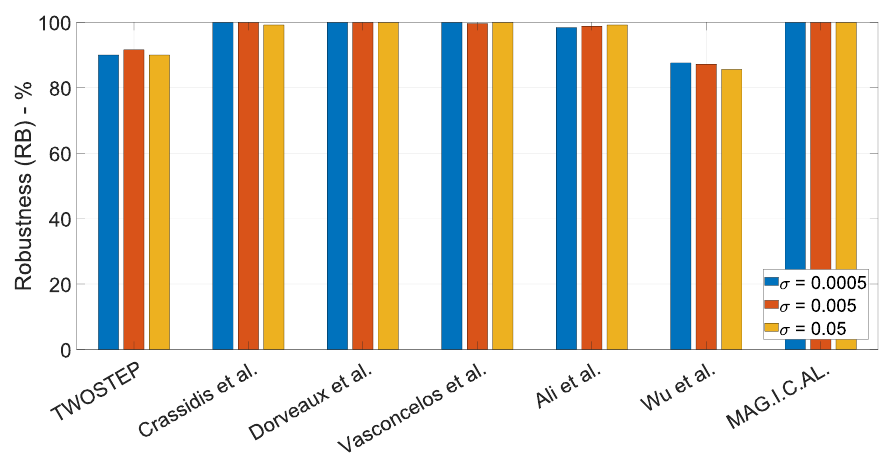
Figure 5. Performance characteristics of the presented algorithms for different values of the noise variance, σ 2